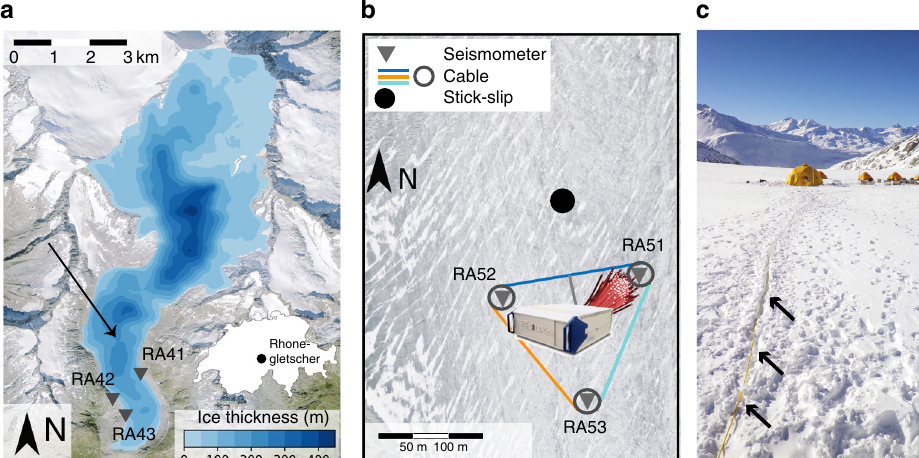
Fig. 1 Study site on Rhonegletscher. a Glacier thickness from interpolated radar pro fi les 21 on orthophoto of year 2014 (ice fl ow from North to South). Triangles indicate on-rock seismometers (model LE3D 5s) and black arrow points toward the location of the region shown in panel ( b ). b Network layout of seismometers and fi ber-optic cable as well as location of stick-slip event shown in Figs. 2, 3, and 4, and located with the DAS records. Orthophoto shows site at almost snow-free conditions in summer whereas the DAS measurements for the present study were conducted on a 3 m snow cover. Residual snow bridges show local crevasses. c Photo of fi ber-optic cable in snow (arrows) and fi eld camp (photo by Manuela Köp fl i). Orthophoto was provided